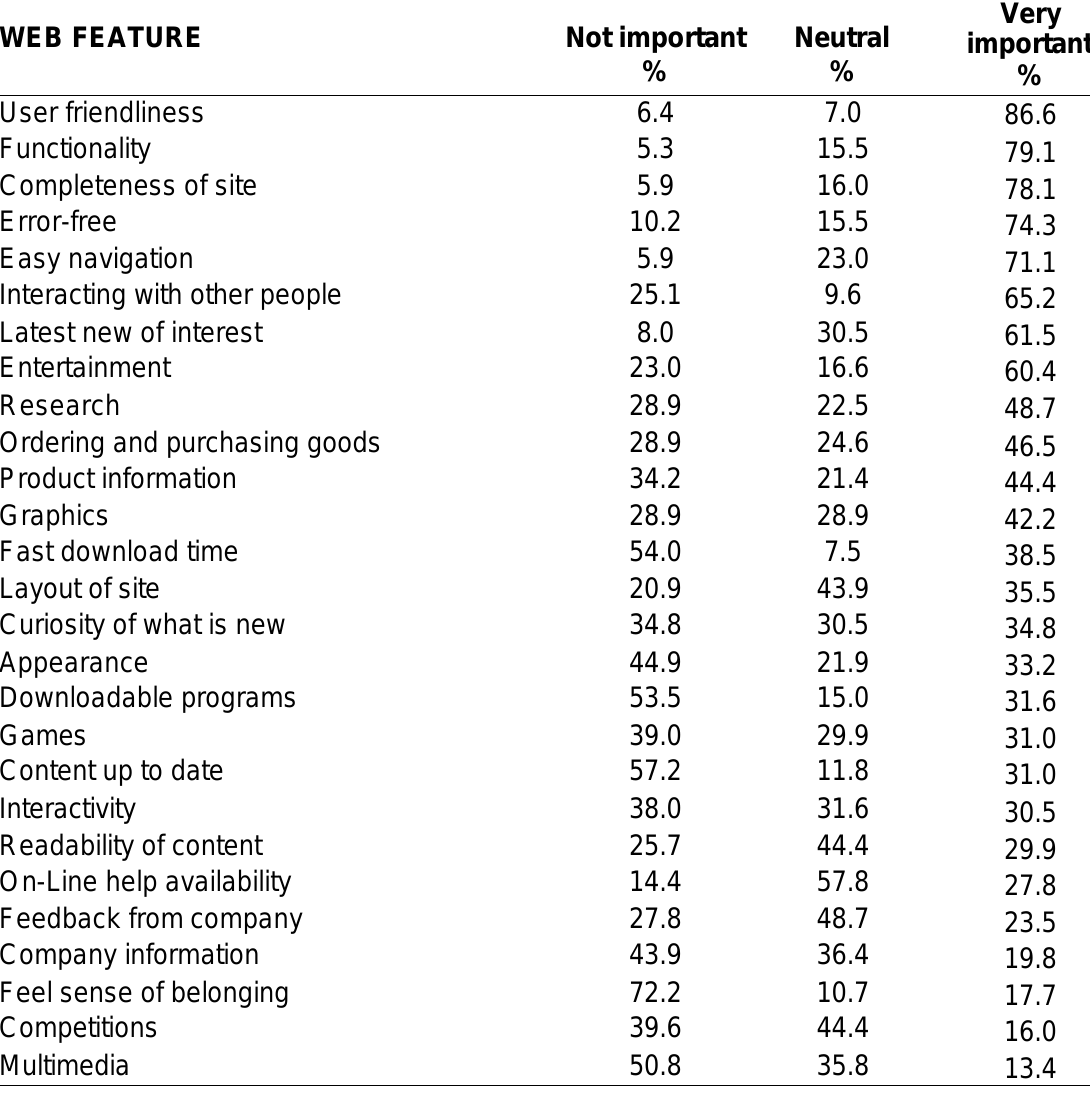
TABLE 5: IMPORTANCE OF FEATURES OF WEB SITES TO INFLUENCE RESPONDENTS TO RETURN TO WEB